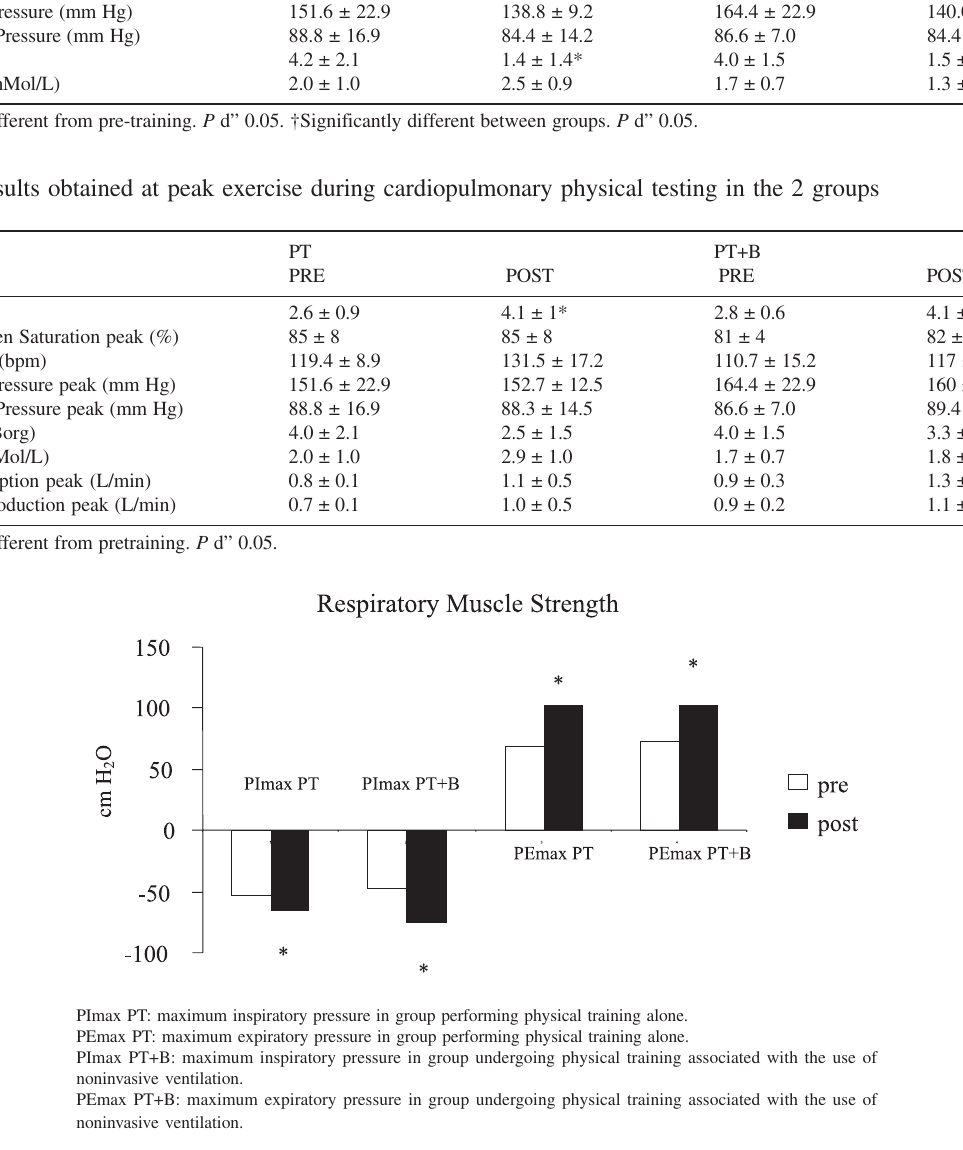
Table 2 - Results obtained at identical exercise levels during cardiopulmonary physical testing in the 2 groups PT PT+B PRE POST PRE POST Speed (km/h) 2.6 ± 0.9 2.6 ± 0.9 2.8 ± 0.6 2.8 ± 0.6 Peripheral Oxygen Saturation (%) 85 ± 8 89 ± 8* 81 ± 4 87 ± 4* Heart Rate (bpm) 119.4 ± 8.9 114.1 ± 11.4 110.7 ± 15.2 103.7 ± 11.5* Systolic Blood Pressure (mm Hg) 151.6 ± 22.9 138.8 ± 9.2 164.4 ± 22.9 140.0 ± 21.9* Diastolic Blood Pressure (mm Hg) 88.8 ± 16.9 84.4 ± 14.2 86.6 ± 7.0 84.4 ± 10.1 Dyspnea (Borg) 4.2 ± 2.1 1.4 ± 1.4* 4.0 ± 1.5 1.5 ± 1.8* Blood Lactate (mMol/L) 2.0 ± 1.0 2.5 ± 0.9 1.7 ± 0.7 1.3 ± 0.7*†